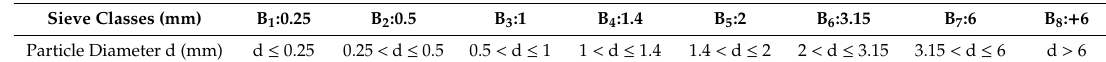
Table 1. Sieve classes of material